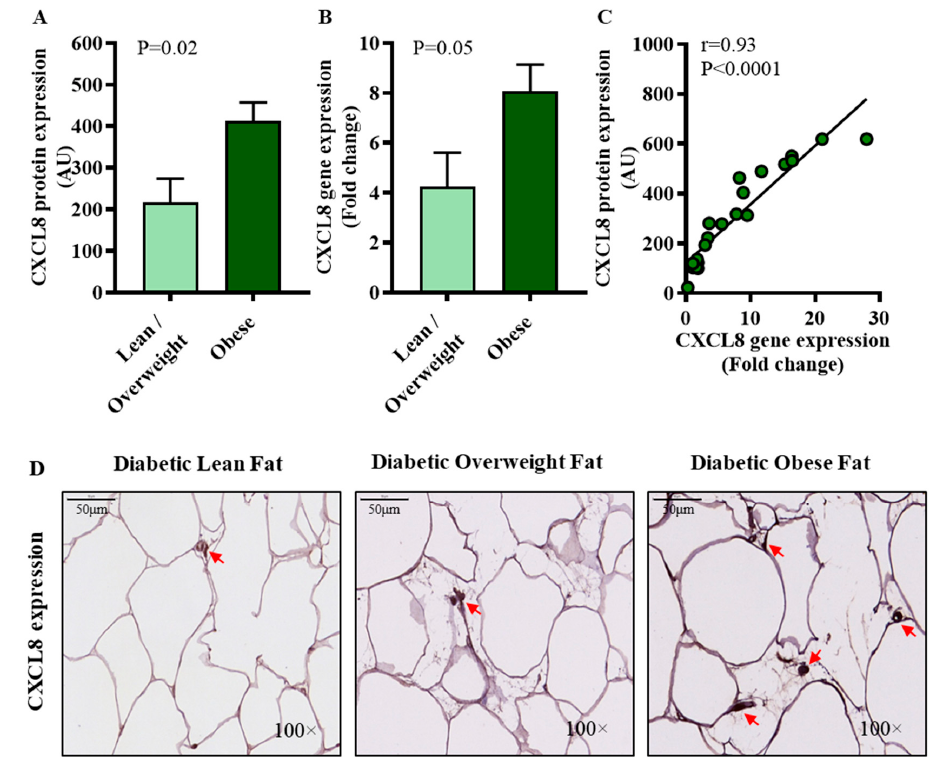
Figure 4. Increased adipose CXCL8 expression in diabetic obese patients. Adipose CXCL8 protein